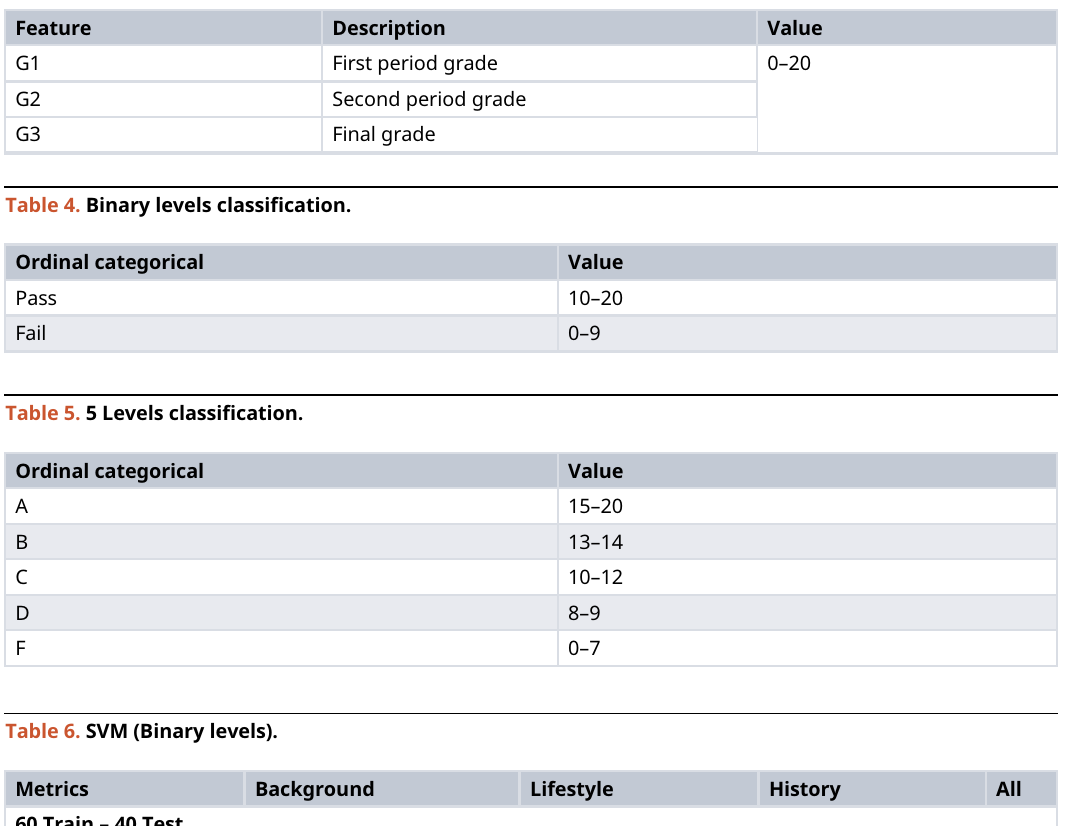
Table 3. Student history of grades.